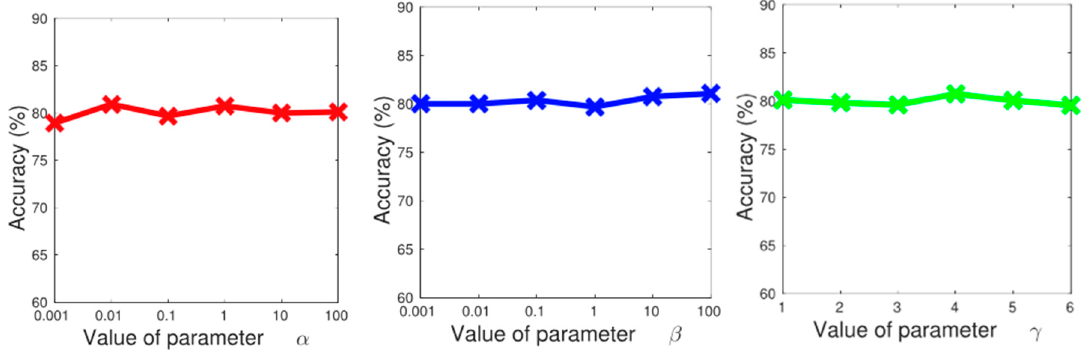
Figure 8. Robustness evaluation of our approach by applying different values of α , β , and γ .